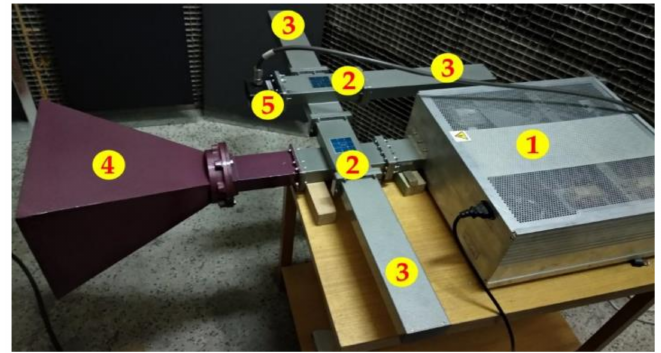
Figure 10. Assembly of a microwave power